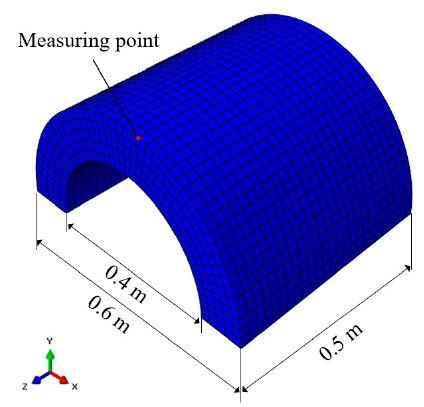
Figure 9. Finite element method modeling of the workpiece.